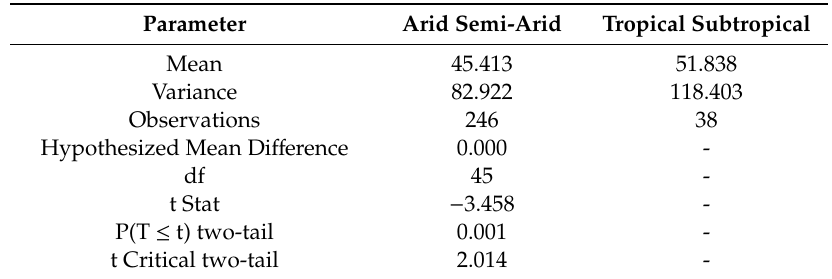
Table 2. T-test assuming unequal variances among the 2 agro-climatic origins.